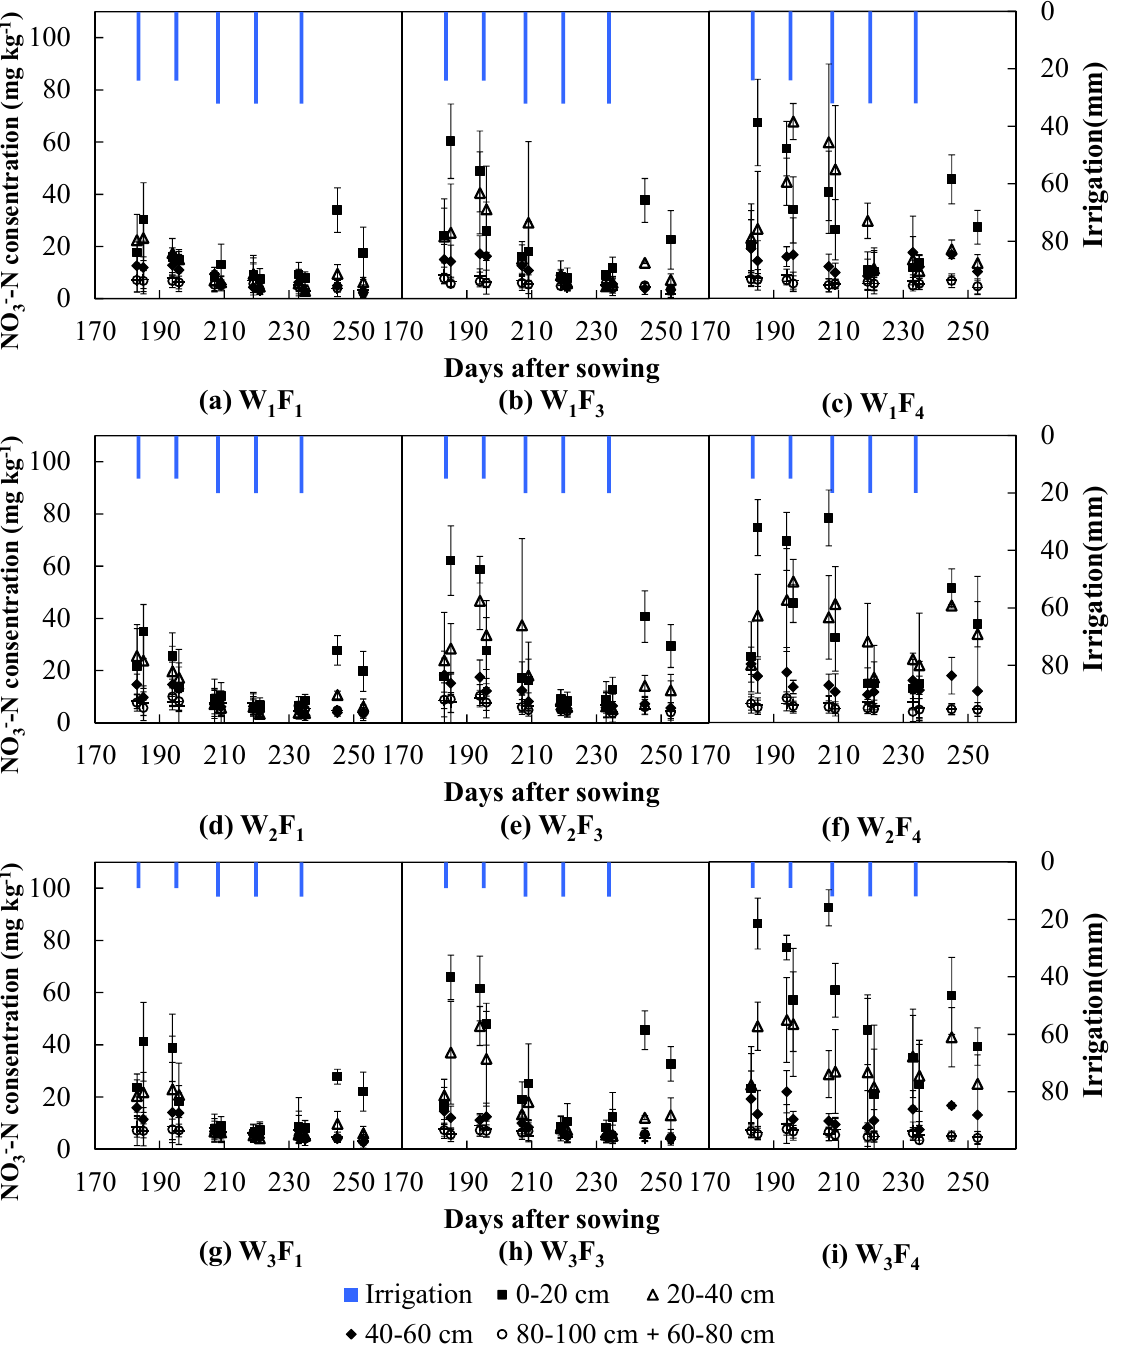
Figure 5. Temporal variation in the NO 3 − -N concentration (mg·kg − 1 ) during the 2013 winter wheat growing season for nine treatments: W 1 , W 2 and W 3 , irrigations scheduled according to 0.8, 0.5 and 0.3 cumulative evaporation of 20-cm-diameter pan (E), respectively; F 1 : N application at 120 kg·ha − 1 ; F 3 : N application at 190 kg·ha − 1 ; and F 4 : N application at 290 kg·ha − 1